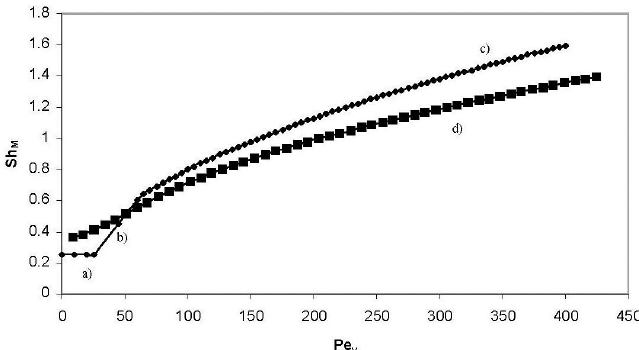
Figure 4. Sh M (Pe y ) trend. The results ( d ) of the numerical calculation compared to the approximate solutions of: ( a ) the diffusive regime; ( b ) the forced flow regime; and ( c ) the forced pellicular regime. B/D = 1; H/D = 0.2; x A1 = x A2 ; limit current.